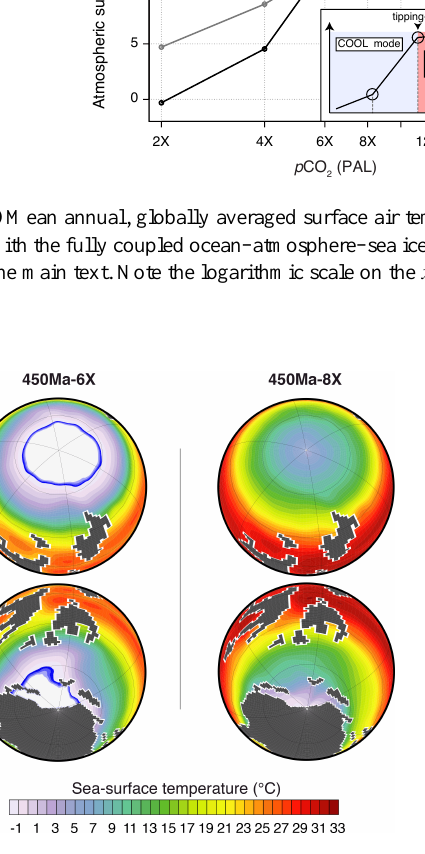
Figure 3. SST (color shading) and permanent sea ice cover (blue- white shading) simulated at 450Ma with the fully coupled version of FOAM within the cold climatic mode (at 6PAL) and within the warm climatic mode (at 8PAL). The permanent sea ice cover is de- fined as the sum of all grid points whose at least 80% of the surface is covered by sea ice during a year, allowing to discard temporary sea ice cover by icebergs or rapidly advancing and retreating ice fronts. The gray mask stands for continental